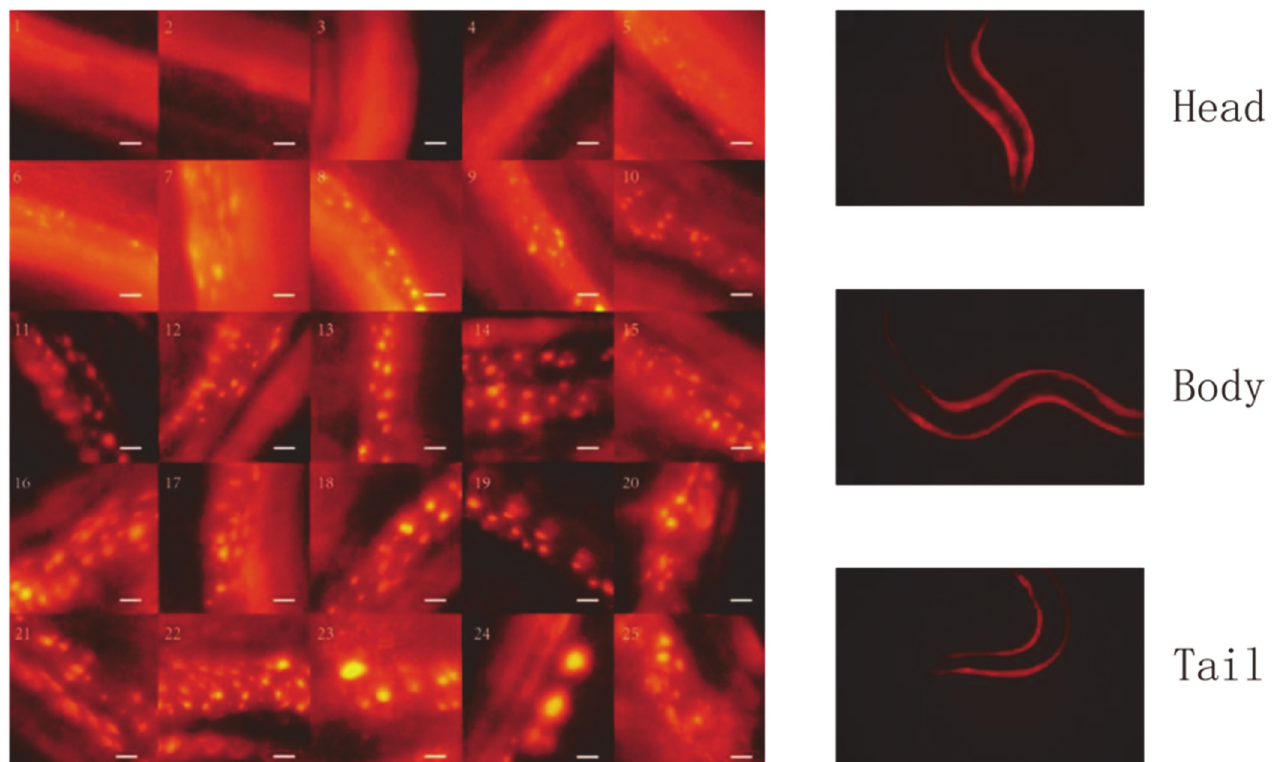
Figure 1. Representative pictures from each class. The serial number in the upper ‐ left area of each picture is the class each picture belongs to. Each class represents a 4% period of time of the whole lifespan of C. elegans (e.g., the picture taken on day 5 of an individual with a 15 ‐ day lifespan would be assigned to class 9). The original photo was 4000 × 6000 pixels. We manually intercepted 300 × 300 pixels of the region with protein aggregation. The pictures in the figure are representative for each class (not from the same individual). Scale bar: 5 μ m (the actual length of the white line is 5 μ m).